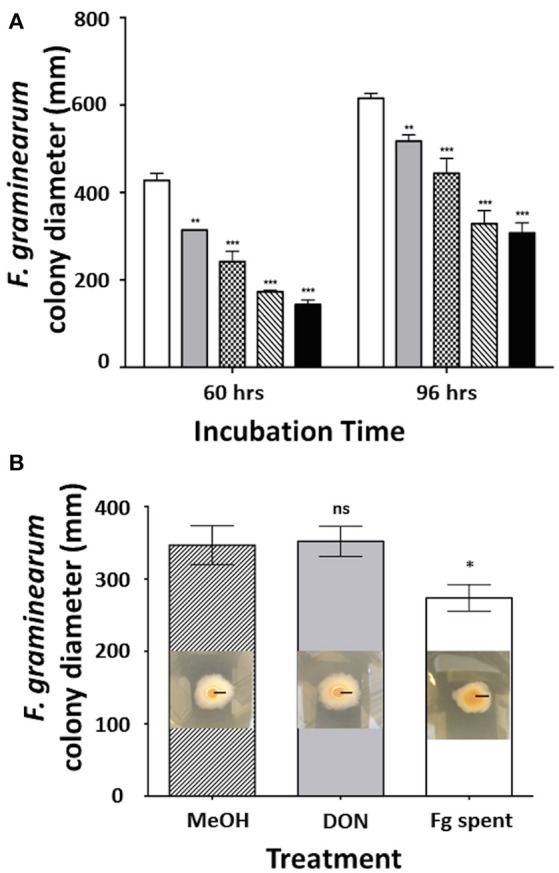
Effect of filter-sterilized secretomes on the C. rosea AMC941-F. graminearum interaction. (A) Effect of increasing concentration of filter-sterilized C. rosea ACM941 culture broth (representing its secretome) on F. graminearum colony size after 60 and 96 h incubation. Bars represent: white: F. graminearum grown on PDA plate overlaid with 2.25 ml of Czapek Dox broth (control); and gray, plaid, diagonal stripe, black: F. graminearum grown on PDA plates overlaid with 375, 750, 1,500, and 2,250 μl of filter-sterilized C. rosea-spent media, respectively. Asterisks indicate level of significance at p < 0.001 and error bars indicate standard error (n = 3). (B) Effect of DON and Fusarium-spent media treatment (applied during the production of C. rosea ACM941 spent-media) on the growth-inhibitory activity of C. rosea ACM941 spent-media. Shown are representative images of F. graminearum grown on PDA plates overlaid with sterilized C. rosea-spent-media obtained after growth in the presence of (i) methanol, (ii) 5 ppm DON, and (iii) 1,000 × diluted F. graminearum spent media containing live macroconidia. Black bar indicates 1 cm. These are embedded in a quantitative plot of the data obtained. Asterisks indicate level of significance at p < 0.001 and error bars indicate standard error (n = 3).